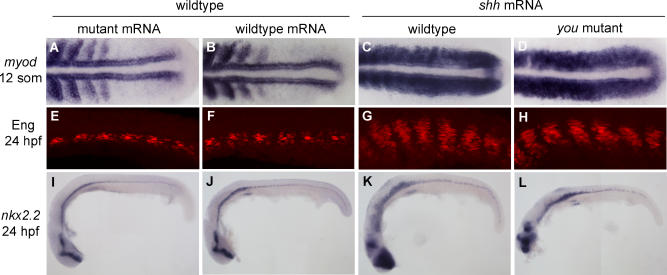
Early Overexpression of you in Wild-type Embryos and Rescue of you Defects by shh mRNA Injection(A–D) Dorsal views of the posterior trunk and tail bud of whole-mount embryos at 12 somites (15 hpf).(E–F) Lateral views of somites 2–7 in 24-hpf embryos.(G–H) Lateral views of somites 8–13 in 24-hpf embryos.(I–L) Lateral views of 24-hpf embryos. Anterior is to the left in all images.When 50 pg of you mRNA was injected into wild-type embryos at the 1–4-cell stage, no obvious expansion of myod (B), Engrailed (F), or nkx2.2 (J) expression was observed when compared either with wild-type embryos injected with equivalent amounts of mutant mRNA (A, E, and I) or with uninjected embryos (see Figure 1). Muscle pioneers were counted in a subset of the embryos; there were 4.0 ± 0.8 Engrailed-expressing muscle pioneers per somite in embryos injected with the control mRNA (n = 3 embryos, 33 somites) and 4.6 ± 1.1 muscle pioneers per somite in embryos injected with synthetic you mRNA (n = 8 embryos, 88 somites). Injection of 50 pg of shh mRNA into embryos at the 1–4-cell stage resulted in expansion of myod, Engrailed, and nkx2.2 expression in both wild-type (C, G, and K) and you mutant (D, H, and L) embryos. shh injection rescued adaxial expression of myod (D), muscle pioneer expression of Engrailed (H), and ventral spinal cord expression of nkx2.2 (L) in genotypically mutant you embryos (compare with Figure 1). Genotypes of all embryos were determined by PCR after photography.